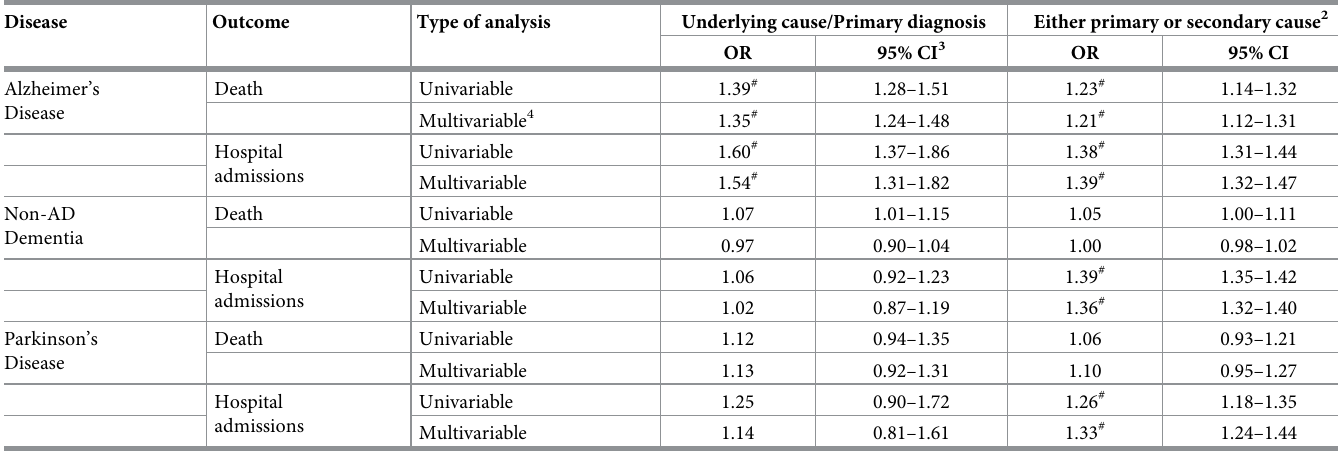
Table 3. Odds ratios (ORs) of death and hospital admissions in the study group 1 . Disease